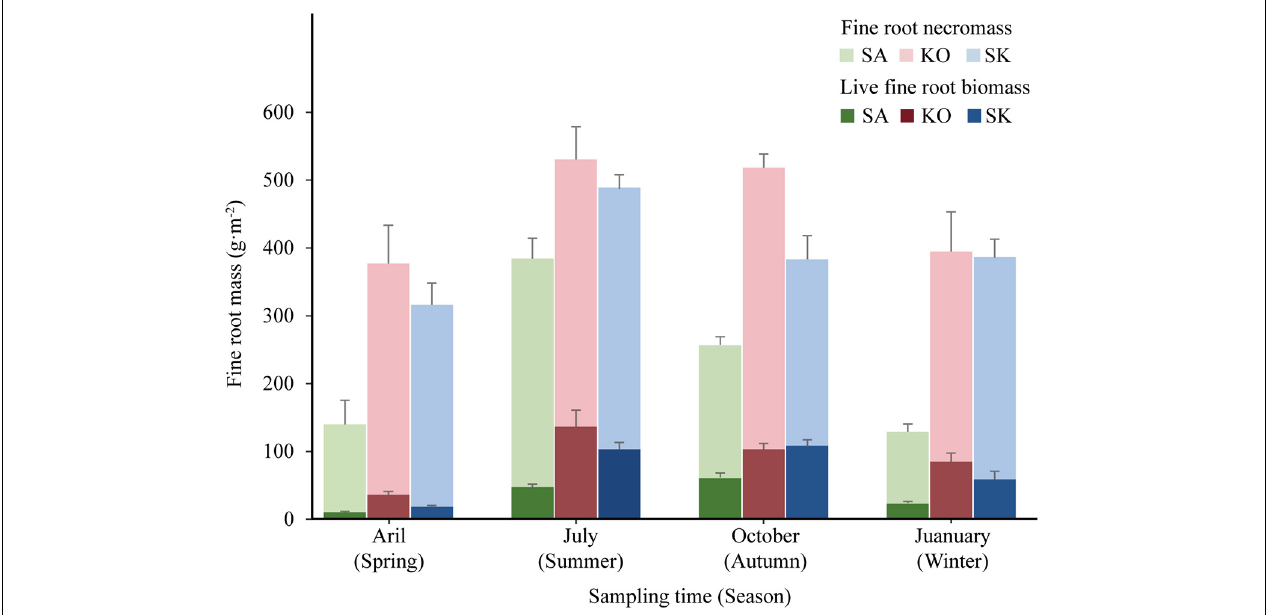
FIGURE 4 | Seasonal variation of live fine root biomass and fine root necromass (mean ± 1SE) in SA, KO, and SK plantation at Hanjiang River Estuary, south China. TABLE 2 | Fine root production (mean ± SE, n = 4 plots) in the three plantations in Hanjiang River Estuary, south China.